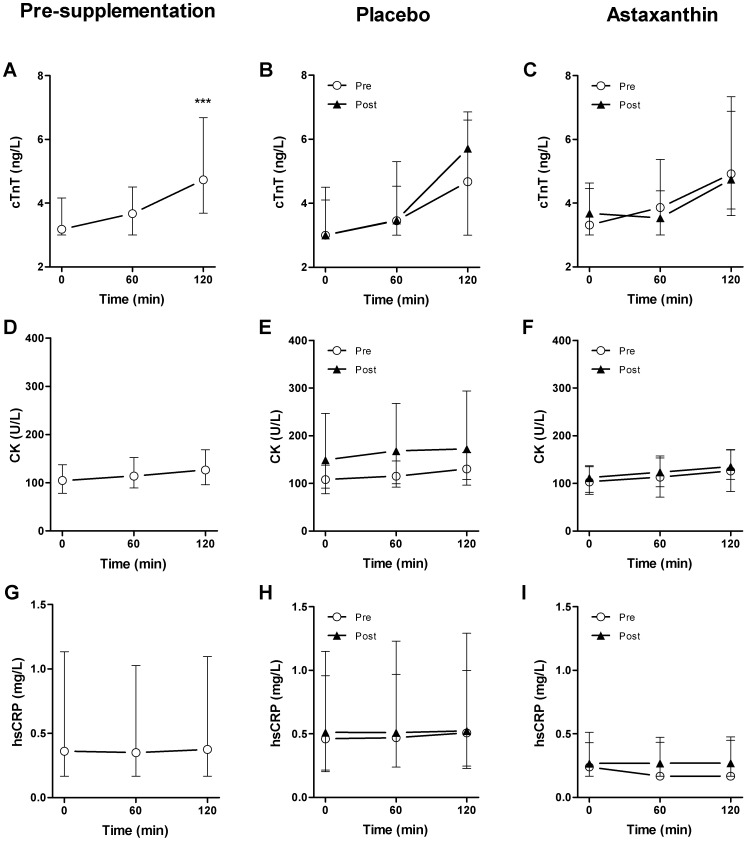
cTnT, CK and hsCRP concentrations during the pre- and post-supplementation exercise trials.A, D, G. Whole group cTnT, CK and hsCRP concentrations during the pre-supplementation exercise trials. B, E, H. cTnT, CK and hsCRP concentrations in the placebo group measured during the pre- and post-supplementation cycling trials. C, F, I. cTnT, CK and hsCRP concentrations in the astaxanthin group during the pre- and post-supplementation trials. ***denotes a significant increase from baseline (P<0.001). Values are median and interquartile range.